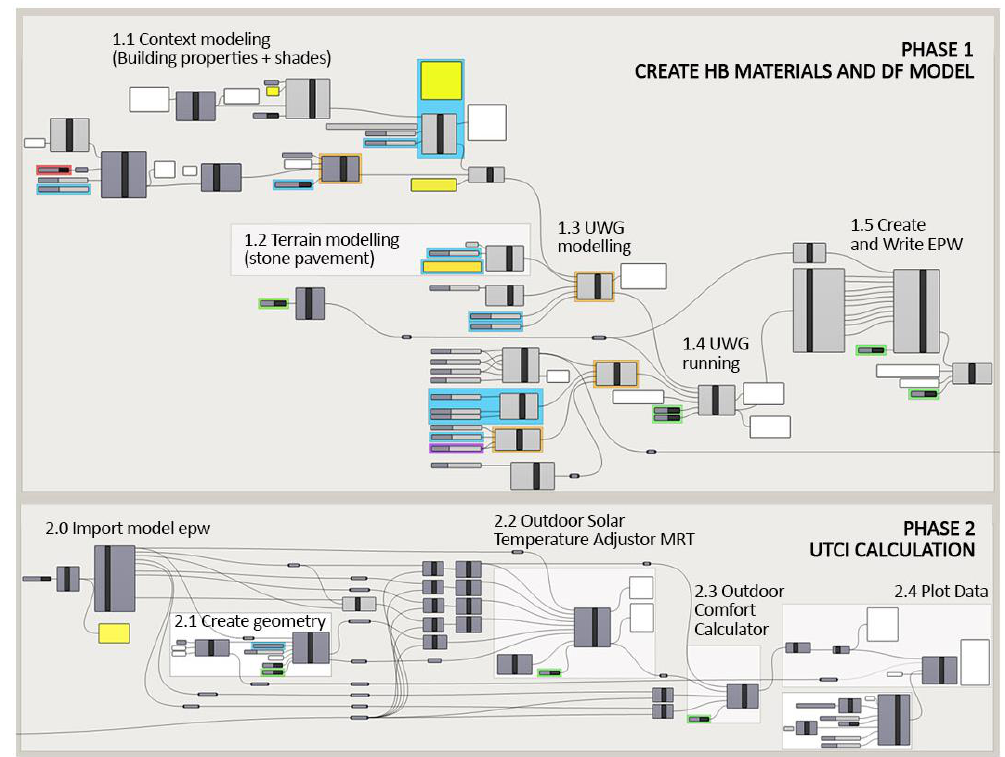
Figure 4. The two phases of the workflow: Phase 1 to create HB materials and DF model (top); Phase 2 for UTCI calculation (bottom).